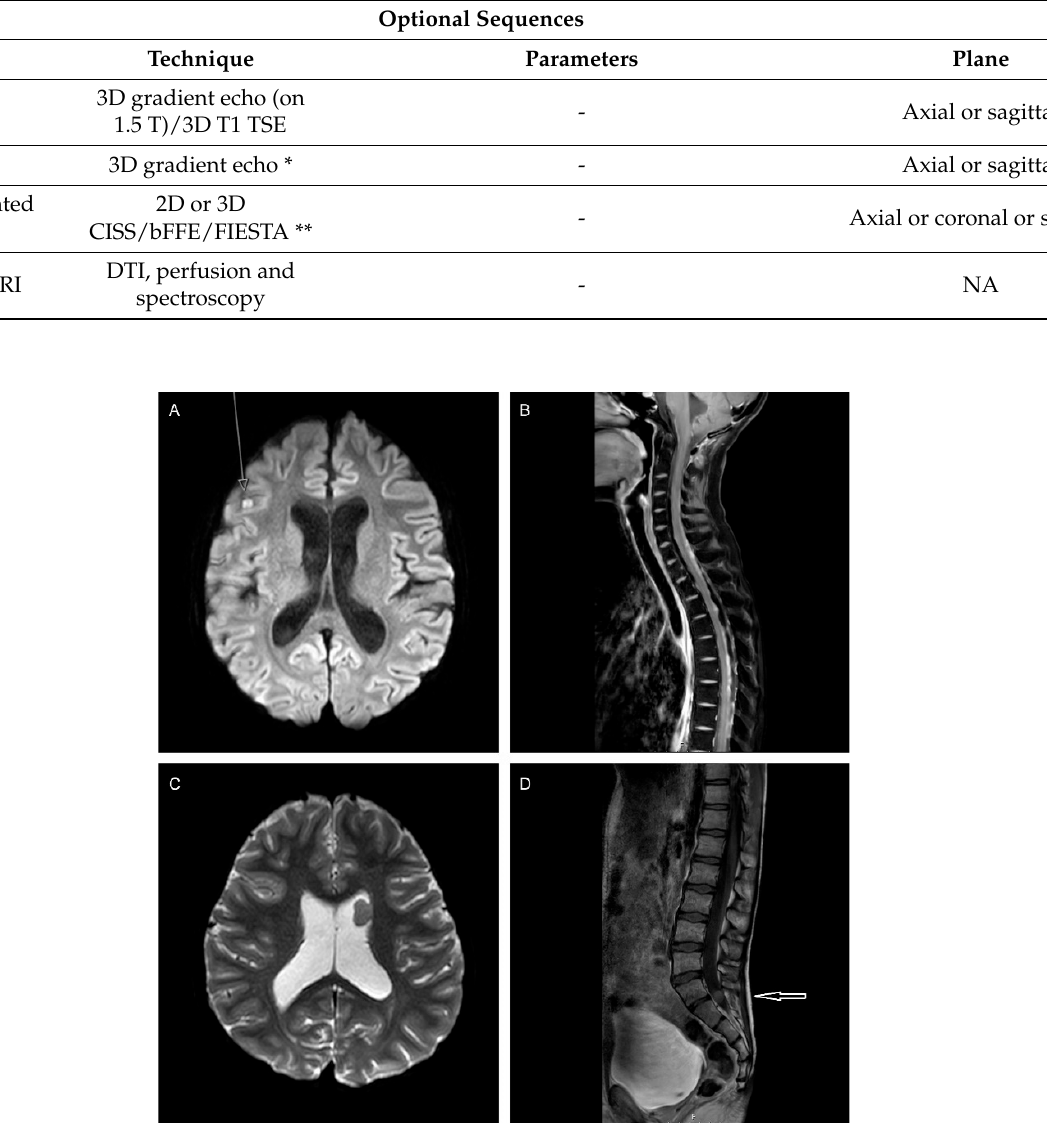
Figure 2. MRI images demonstrating varying patterns of disease relapse in medulloblastoma. ( A , B ). A 15-year-old patient with a non-metastatic MB Group4 at diagnosis, treated initially with CSI and chemotherapy. Six months following the end of treatment, leptomeningeal metastases are detected in the right cerebral hemisphere (( A ), axial b 1000) and spine (( B ), post-contrast sagittal T 1 W DIXON). ( C ). An 11-year-old patient with a non-metastatic MB Group4 at diagnosis, treated initially with CSI and chemotherapy. Three years following end of treatment, an intraventricular metastasis is discovered in the left frontal horn (axial ADC map). ( D ). A 14-year-old patient with a non-metastatic MB Group4 at diagnosis, treated with CSI and chemotherapy. Two years following CSI, an intraspinal relapse at S1–S2 is noted (post-contrast sagittal T 1 W DIXON). Table 1. Essential and optional brain Magnetic Resonance Imaging sequences. * 3D FLAIR can be used instead of 2D FLAIR but not if 2D sequences have been used for the same individual on previous occasions. ** The heavily weighted T 2 W sequence localised to a region of interest is useful in assessment of lesions (in particular poorly/non-enhancing) within the extra-axial space or along the parenchymal surface. SE, Spin Echo; TSE, Turbo Spin Echo; FSE, Fast Spin Echo; MP-RAGE, Magnetisation-Prepared Rapid Gradient-Echo; IR, Inversion Recovery; SPGR, Spoiled Gradient Recalled echo; TFE, Turbo Field Echo; FFE, Fast Field Echo; DWI, diffusion-weighted imaging; ADC, Apparent Diffusion Coefficient; EPI, Echo Planar Imaging; CISS, Constructive Interference in Steady State; bFFE, balanced Fast Field Echo; FIESTA, Fast Imaging Employing Steady-state Acquisition; DTI, Diffusion Tensor Imaging; NA, not applicable. Essential Sequences: 1.5 Tesla Scanner Sequence